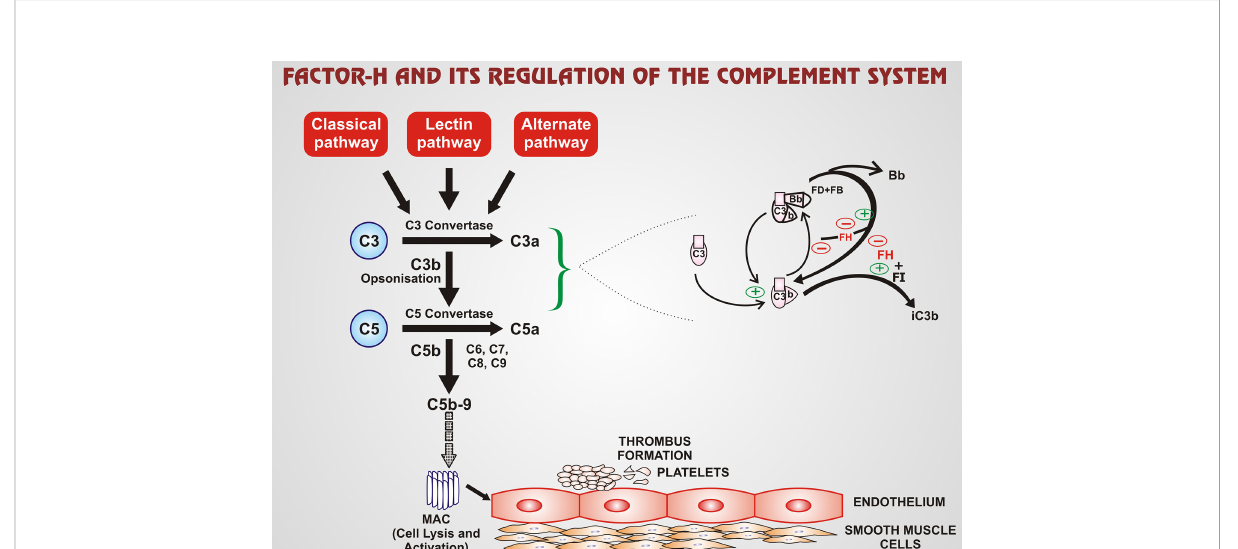
FIGURE 1 FH is an important regulatory protein of the complement pathway, with its effect mainly on the alternate pathway of the complement system. FH regulates the complement system via two mechanisms: DAA and CA. DAA enables FH to displace Bb fragment of FB off C3 convertase. Thus, the accelerated irreversible decay of C3bBb into C3b and Bb takes place. In the CA mechanism, FH has the role of a facilitator in the FI-mediated cleavage of C3b to iC3b, which is an inactivated form of C3b. The green ‘ + ’ arrows exhibit stimulatory or enhanced action whereas red ‘ - ’ arrows exhibit inhibitory action. Thus, over-ampli fi cation of the complement pathway is regulated by FH. The C5b-9 is one of the terminal components of the MAC which mediates the cell lysis and activation completing the complement cascade. The broken arrow implies that MAC enhances the process of thrombus formation from platelets which consists of a series of steps. (FH-factor-H; FI-factor-I; FB-factor-B; FD-factor-D; MAC-membrane attack complex; DAA-decay accelerating activity; CA-co-factor activity; iC3b-inactivated